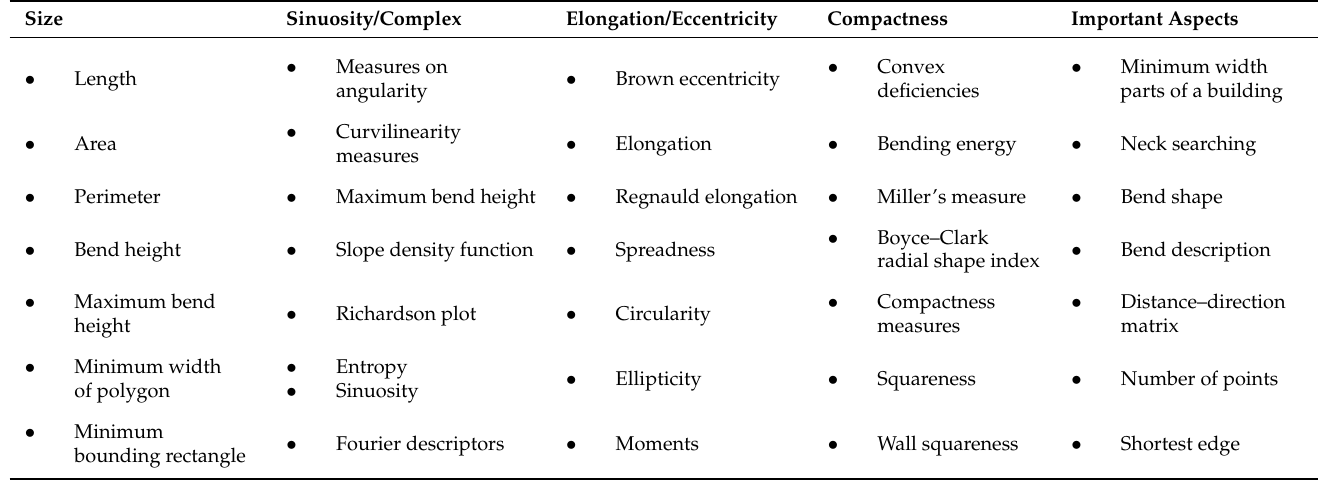
Table 1. Copy of the AGENT measures [15] showing linear and polygonal shape measures used in past research summarized in